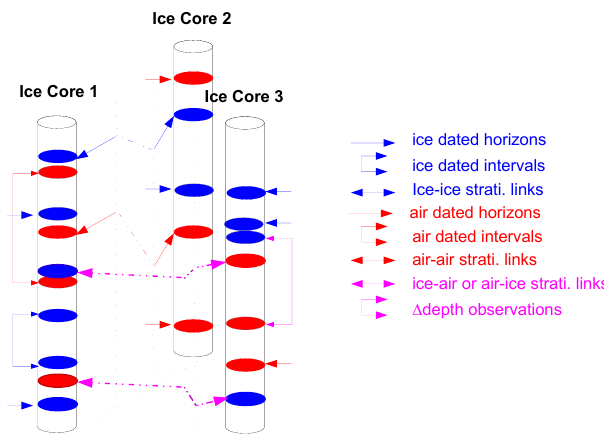
Figure 1. Scheme illustrating the different kinds of observations used to constrain the chronologies of the ice cores in the IceChrono1